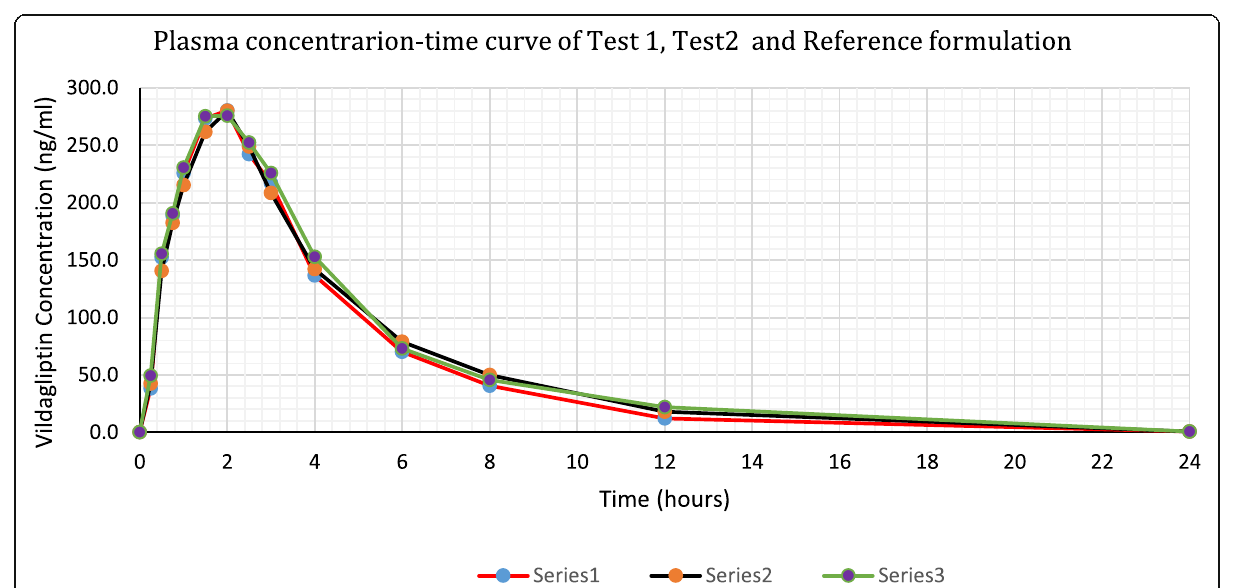
Fig. 1 Mean plasma concentrations of vildagliptin after the administration of test 1, test 2, and reference formulations. Here, series 1 = test 1, series 2 = test 2, and series 3 =